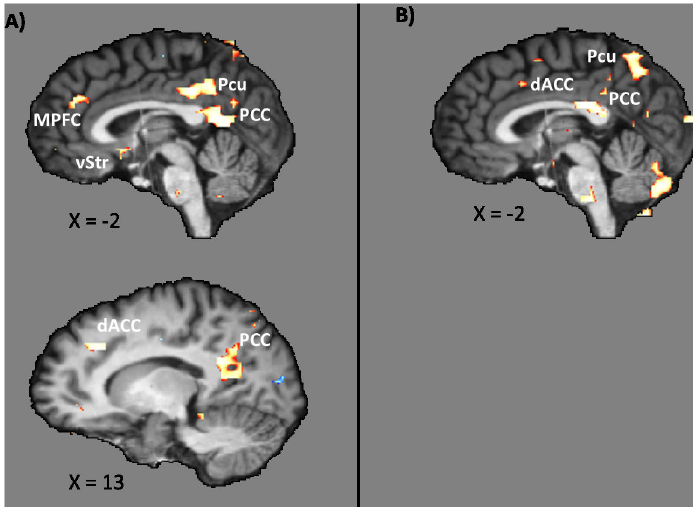
Figure 2. Contrasts of today trials with delay trials in A) SELF, and B) OTHER. Abbreviations: dACC: dorsal anterior cingulate cortex, MPFC: medial prefrontal cortex, PCC: posterior cingulate cortex, Pcu: precuneus, vStr: ventral striatum.